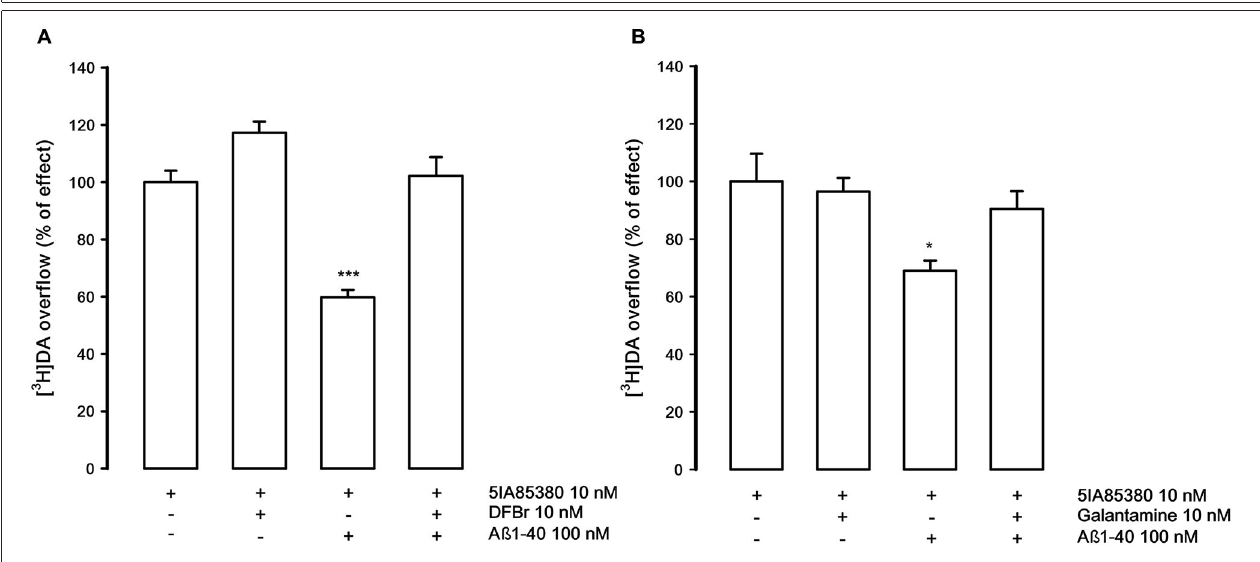
and 5IA85380 (10 nM) respectively. One-way ANOVA followed by Bonferroni post-hoc test.